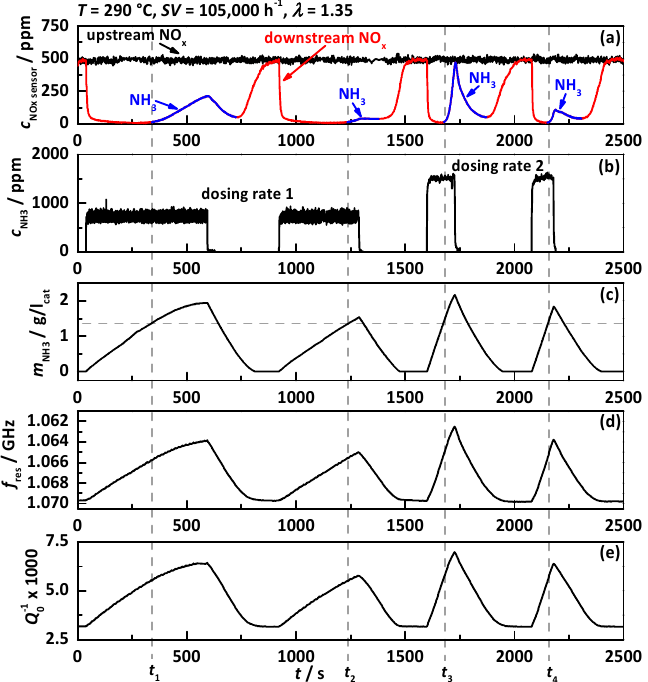
Figure 3. Experiment at 290 °C with SV = 105,000 h − 1 and λ = 1.35 and two DEF dosing rates: ( a ) NO x sensor signal upstream of DEF dosing (black) and downstream of SCR catalyst (red: assigned to downstream NO x , blue: assigned to downstream NH 3 ); ( b ) dosed NH 3 concentration determined by NO x sensor signals up- and downstream of DEF dosing; ( c ) calculated amount of NH 3 stored on the catalyst; ( d ) resonance frequency f res in reverse scale and ( e ) the reciprocal unloaded quality factor Q 0 − 1 . The dashed lines indicate the loading level when first NH 3 slip occurs.